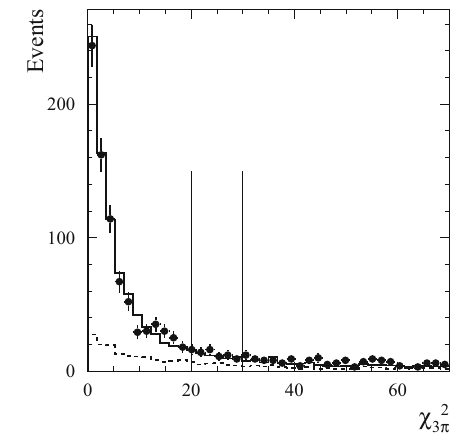
√ Fig. 1 The χ 2 s = 1 . 44 GeV distribution for data events with 3 π (points with error bars). The solid curve is a sum of simulated distri- butions for signal and background events. The dashed curve shows the background contribution. The simulated distributions are normalized to the numbers of signal and background events determined from the fit to the two-photon invariant mass distribution. The lines indicate the cuts < 30) and for dynamics study used for cross section measurement ( χ 2 3 π < ( χ 2 3 π